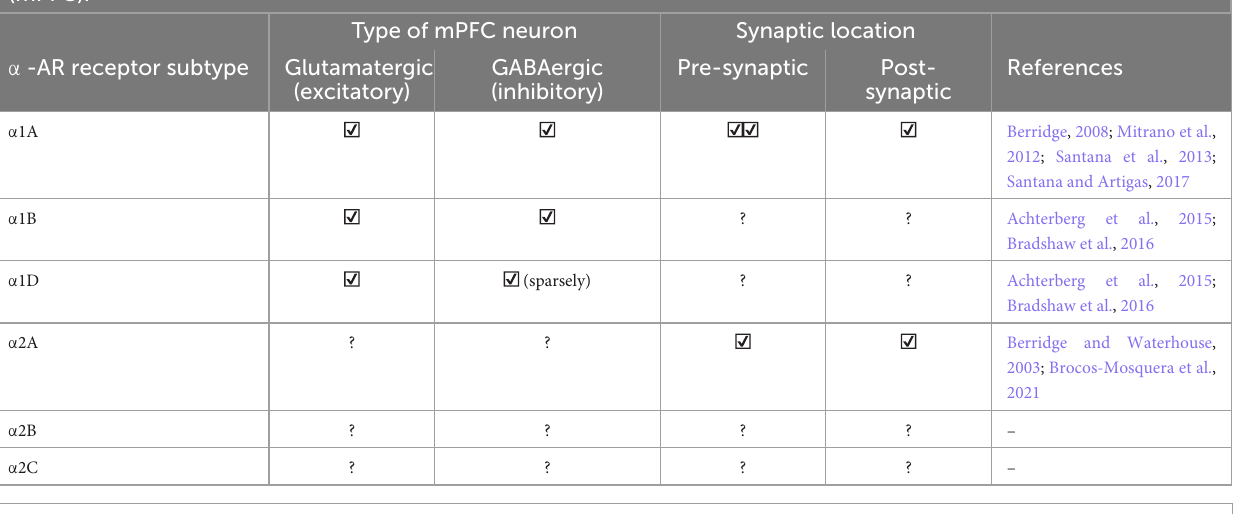
B) Presence of α -adrenergic receptor subtypes on excitatory and inhibitory neurons in the medial prefrontal cortex TABLE 1B